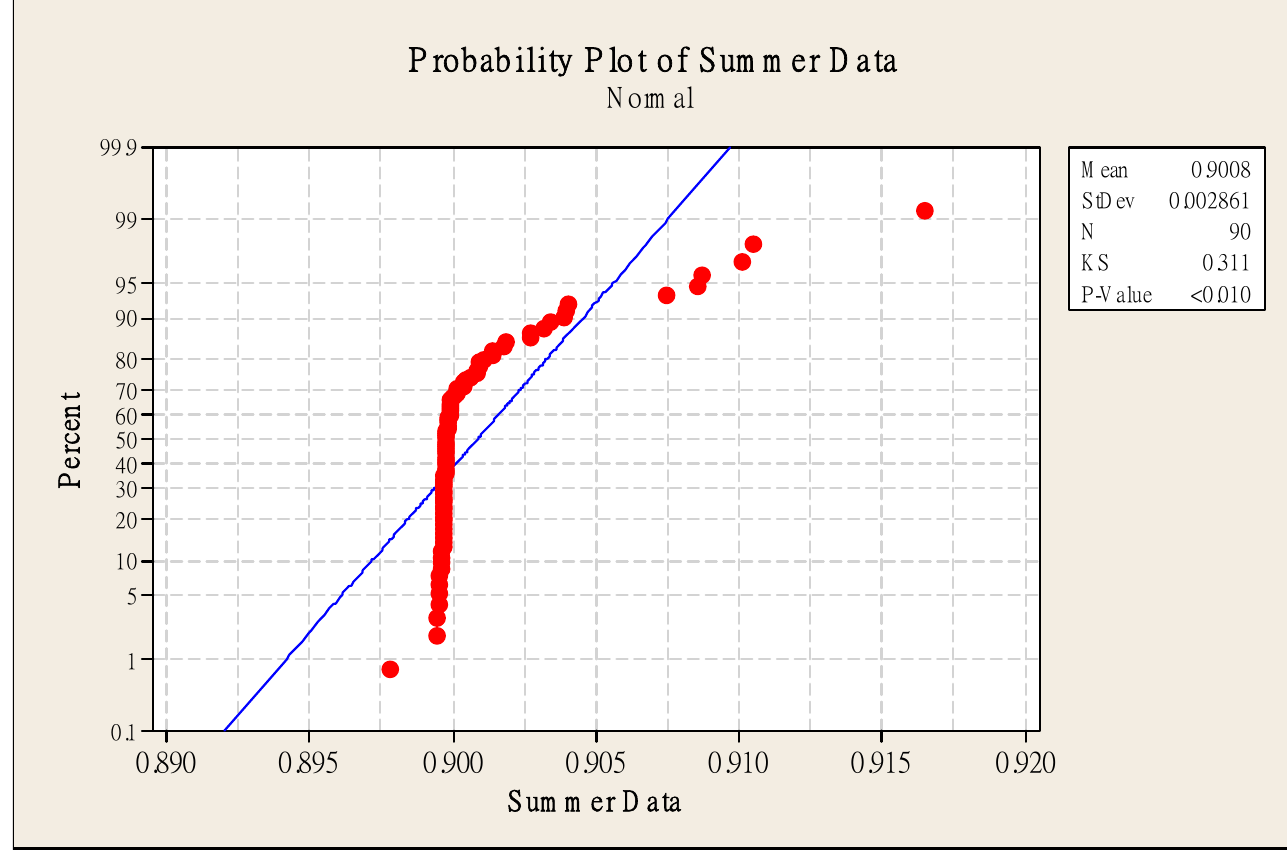
Figure 5. Normality test for summer. Table 12. Friedman’s test, summer—DE blocked by SSO.